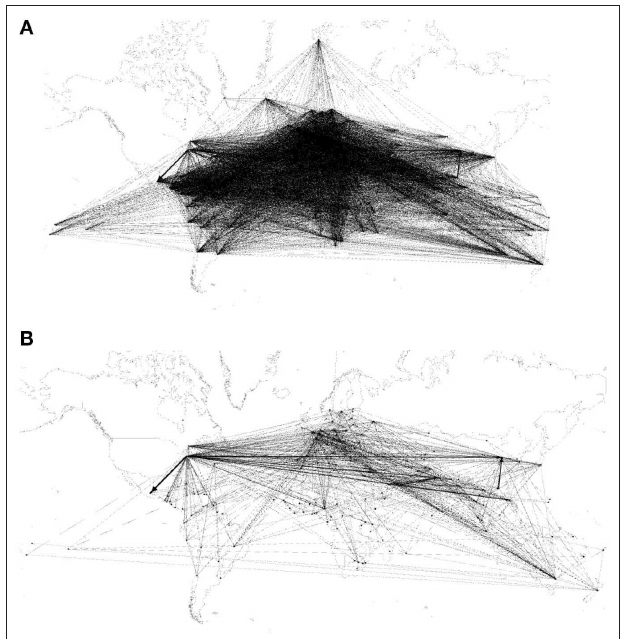
FIGURE 2 | Global remittance network. (A) Before filtering. (B) After filtering.